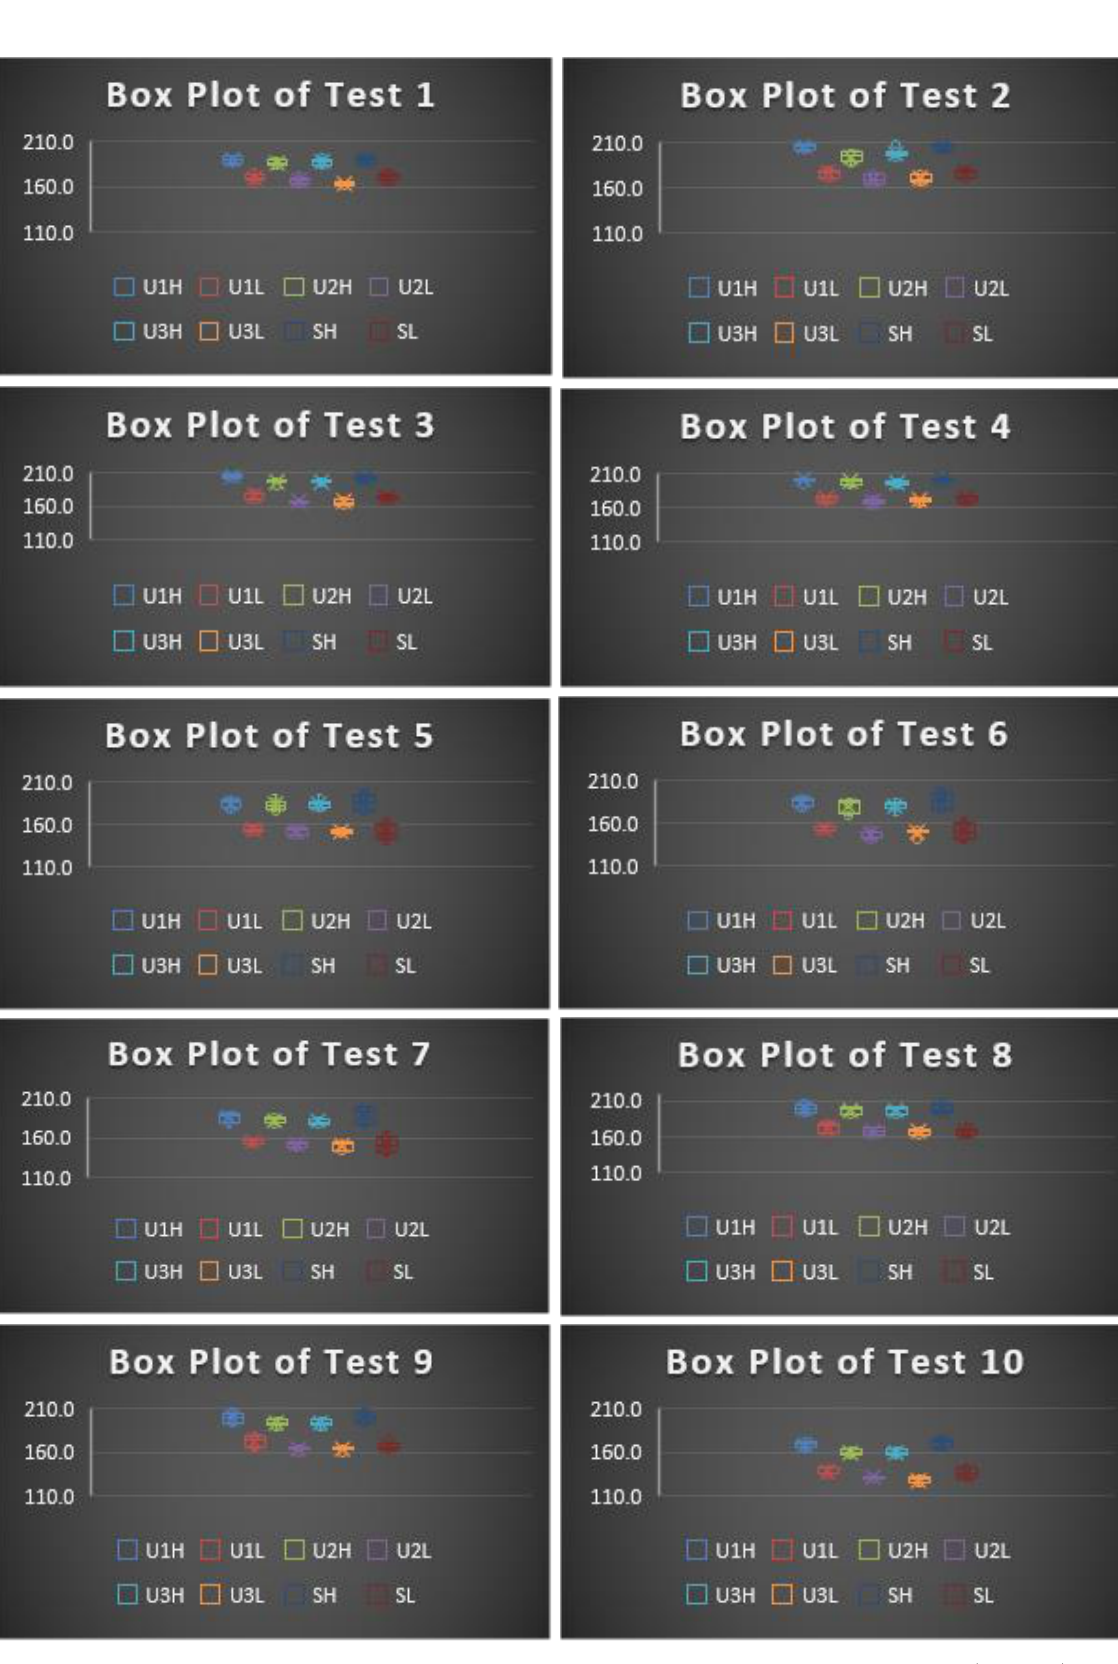
Figure 3. Box-and-Whisker diagram showing data dispersion pattern of the inhibition zone diameters (mm x 10) in each treatment groups of the microbiological assay plates of